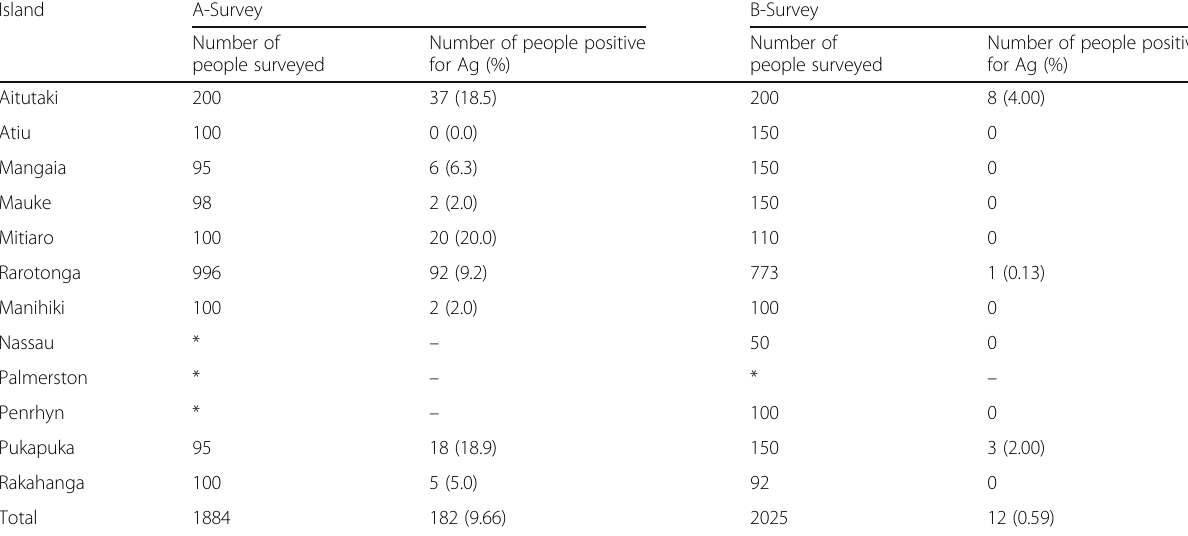
Table 2 Details of A-Survey (baseline survey 1999) and B-Survey (mid-term survey 2002) Island